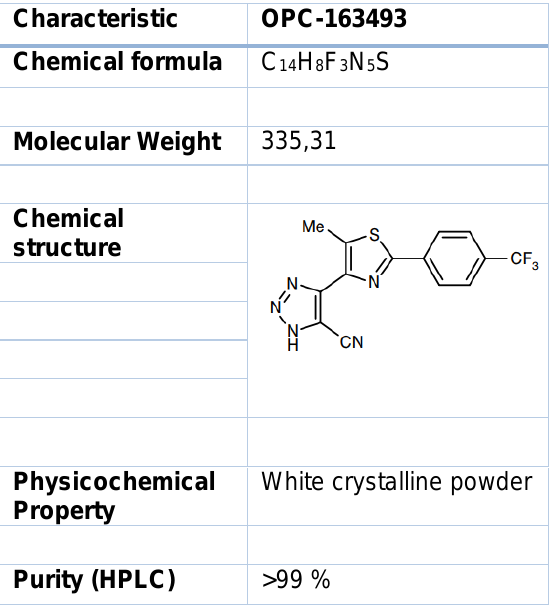
Table 1: Physicochemical property of OPC-